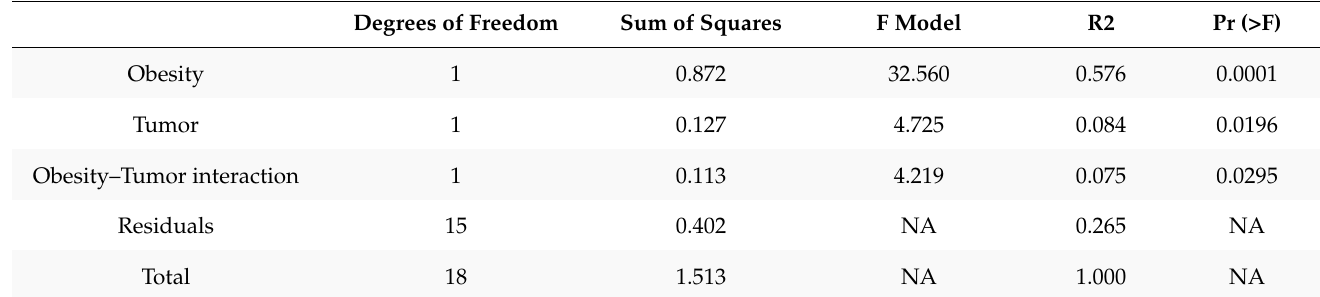
Table 3. PERMANOVA: analysis of variation of functional groups.